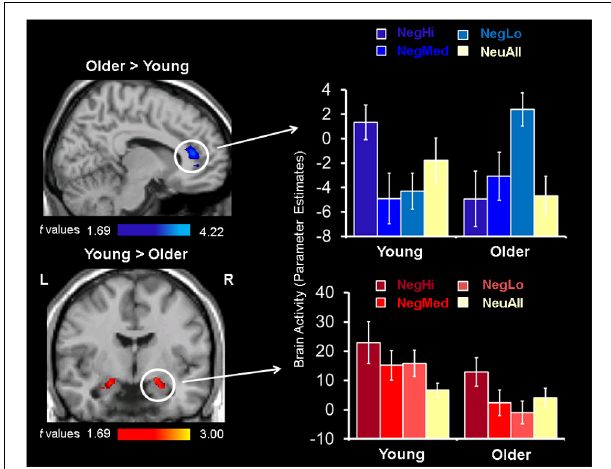
FIGURE 2 | Opposing patterns of response in rostral/ventral ACC and AMY for low arousing stimuli. Increased activity in rostral/ventral ACC (top sagittal image), and decreased activity in the amygdala (bottom coronal image) in older compared to young adults was identified using two-sample t -tests between activation maps for NegLo vs. NeuAll contrast in the two groups. The bar graphs on the right illustrate the parameter estimates corresponding to the peak voxels in the area of ACC and AMY showing increased activity to low arousing negative stimuli in the young and older groups. L, left; R, right; NegHi, Negative Hi Arousal; NegMed, Negative Medium Arousal; NegLo, Negative Low Arousal; NeuAll, Neutral All.